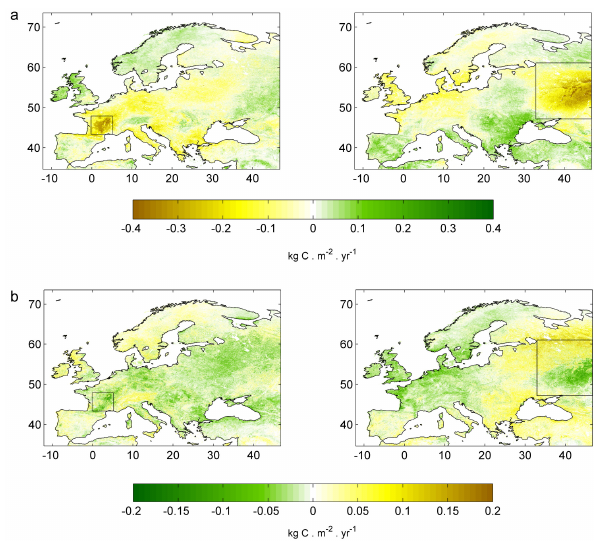
Figure 3. (a) Climatology of the seasonal cycle of monthly PsN (as obtained from MOD17A2 algorithm in kgCm − 2 month − 1 ) for the reference period 2000–2011 averaged over the two selected re- gions HW03 (left) and HW10 (right). Light grey interval delimits the 10 and 90% percentiles; dark grey delimits the 25 and 75% percentiles; solid black line corresponds to the median. Dashed bold line corresponds to the seasonal cycle for the heatwave years, 2003 for HW03 and 2010 for HW10 and the corresponding seasonal anomalies are represented in the bottom panel. (b) as in (a) but for monthly fAPAR from